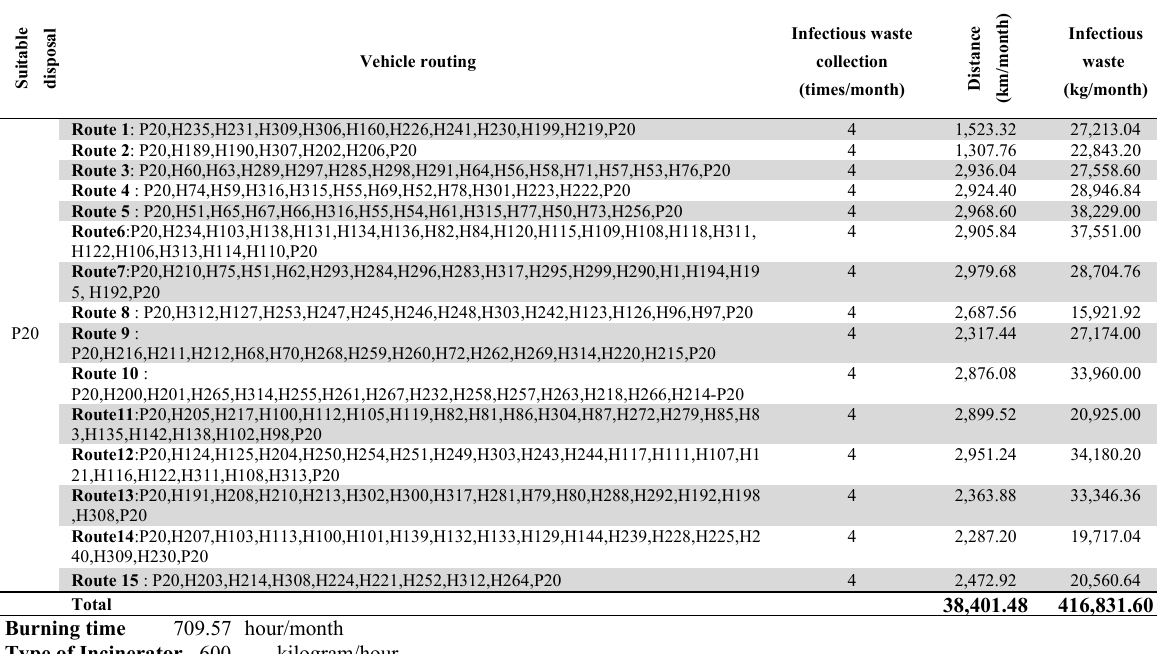
The result of case study with the